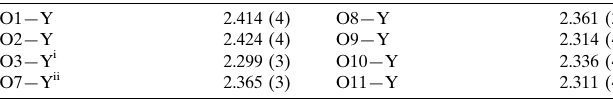
Selected bond lengths (A˚ ).